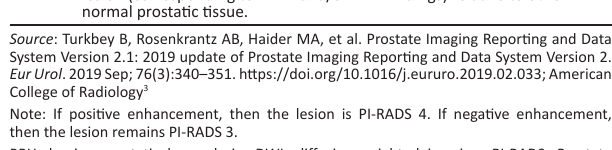
TABLE 3: PI-RADS features of prostatic lesions according to dynamic contrast enhanced characterisation in the peripheral zone. Score Findings Negative No early enhancement or diffuse multifocal enhancement NOT corresponding to the lesion of suspicion OR focal enhancement corresponding to a lesion with features of BPH on T2WI, including extruded BPH. Positive Focal and earlier than or contemporaneous enhancement of a suspicious lesion (corresponding to T2WI and/or DWI findings) relative to other normal prostatic tissue.